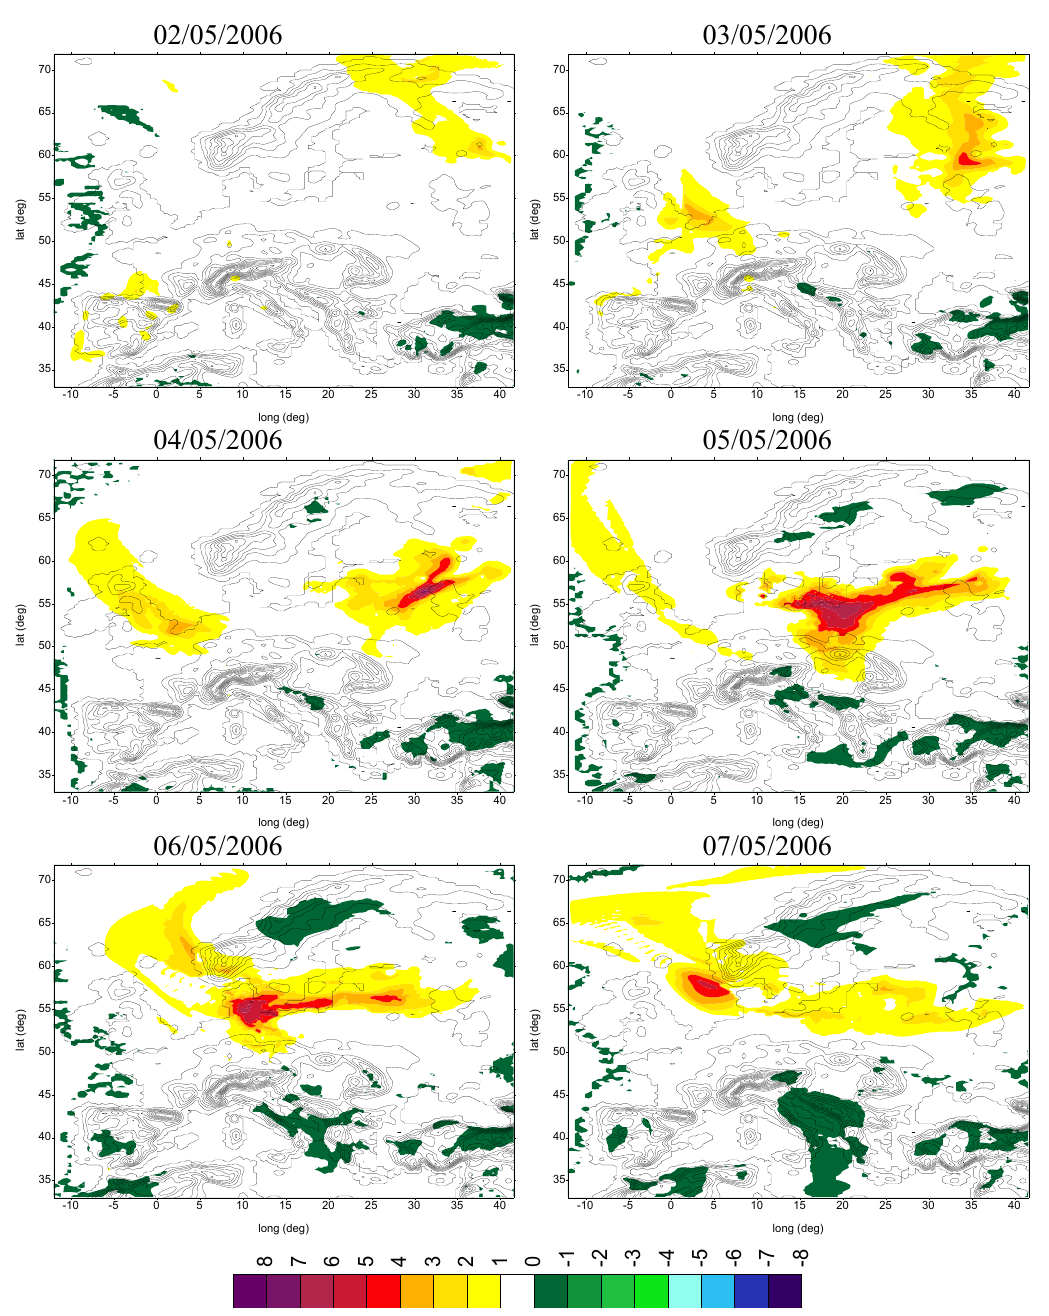
Fig. 12. Total contribution of biogenic emissions to maximum hourly surface O 3 (ppb) during the period 2–7 May 2006.